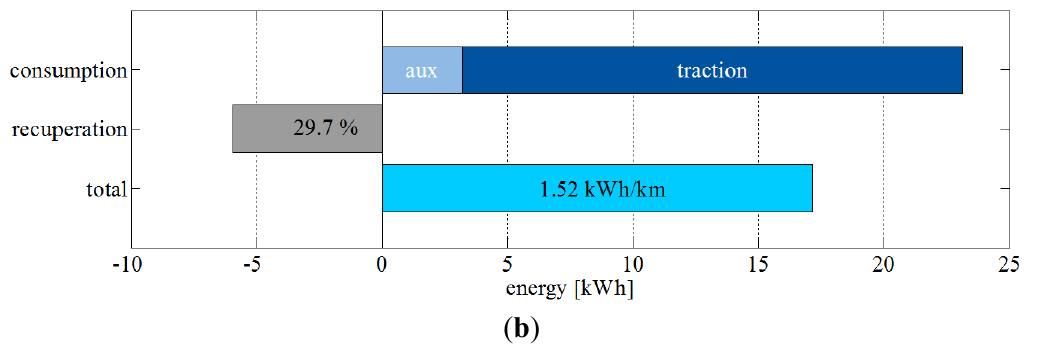
Figure 4. Speed profile and energy consumption of bus route 14 in Münster.